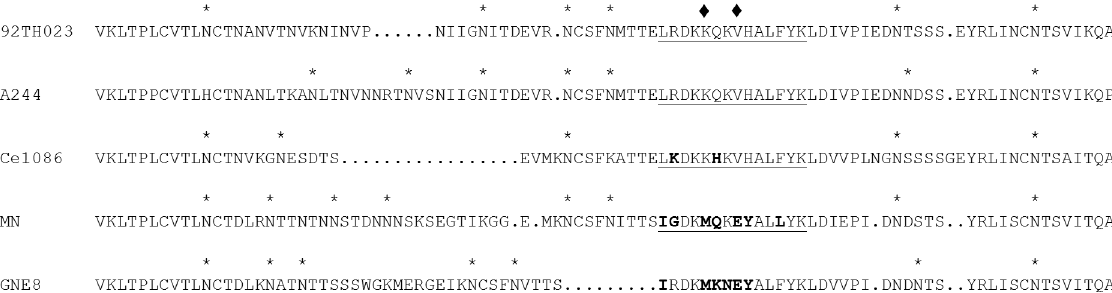
Fig 1. V1V2 sequences in the gp70 scaffolds. Shownis an amino acid sequencealignment of the V1V2 and flankingregions used as gp70-V1V2 scaffolds (with the exceptionof GNE8) to assess complement-activating antibodies. The hotspot peptide region(aa 165–178)targeted by V2 antibodies in RV144[6, 7] is underlined. Amino acids in this hotspot that differ from TH023.6 and A244 are shown in boldfacetype. Lysine (K) at position 169 and valine(V) at position172 are indicatedby a solid